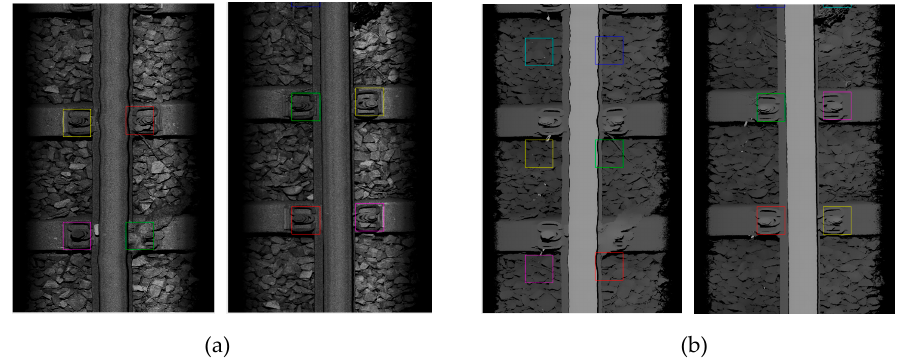
Figure 13. Example of positioning results of rail fastener area: ( a ) Two intensity maps; ( b ) Two depth maps.